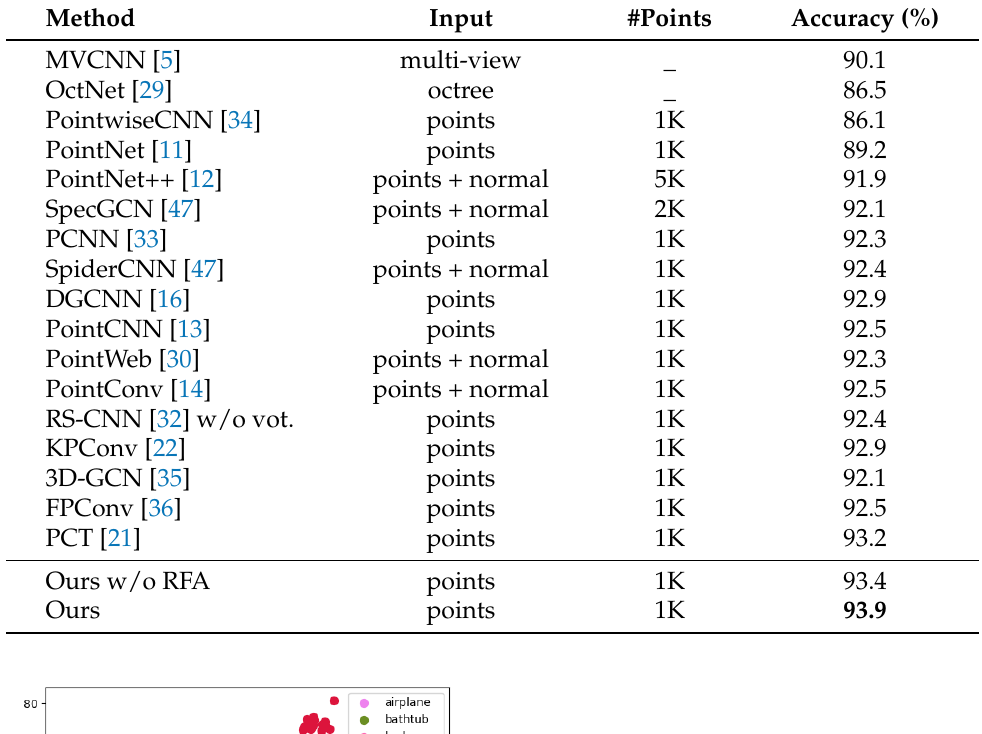
Table 1. Comparison of classification accuracy on ModelNet40.